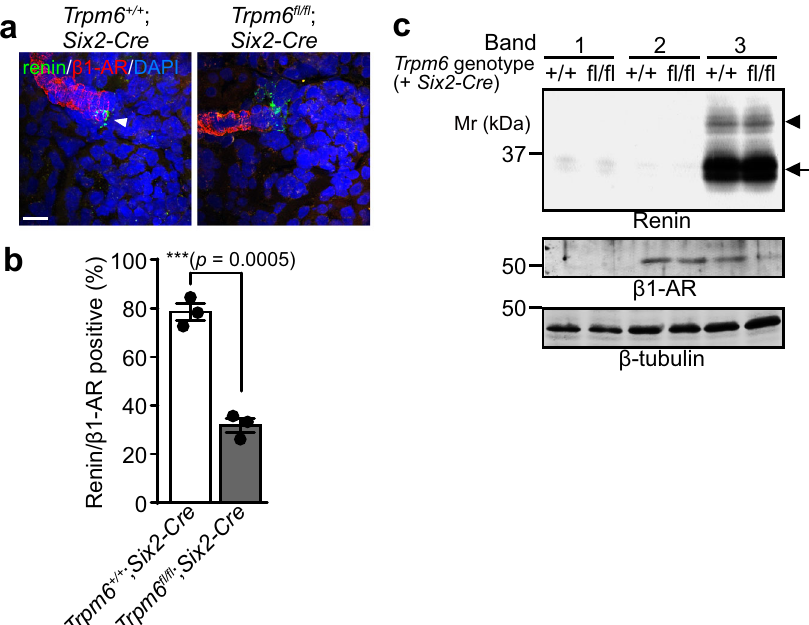
Fig. 5 Decreased β 1-AR expression in JG cell. a Cryosections of 2-month-old Trpm6 + / + ; Six2-Cre and Trpm6 fl / fl ; Six2-Cre mouse kidneys were subjected to immuno fl uorescence staining with an anti-renin antibody (green), an anti- β 1-AR antibody (red), and DAPI (blue). Bar, 20 μ m. A representative result from three independent experiments with similar results are shown. b The percentages of glomeruli with adjacent renin/ β 1-AR-double-positive cells are shown as means ± SEM ( n = 3). The p -values were determined by Student ’ s two-tailed t -tests (unpaired). *** p < 0.001. c Kidneys dissected from 2-month-old Trpm6 + / + ; Six2-Cre and Trpm6 fl / fl ; Six2-Cre mice were treated with trypsin and collagenase, and dispersed cells were separated using Percoll density gradient centrifugation. Cells in each band were collected, and the cell lysates were subjected to immunoblotting with indicated antibodies. Arrowhead and arrow indicate precursor and processed mature form, respectively. A representative result from three independent experiments with similar results are